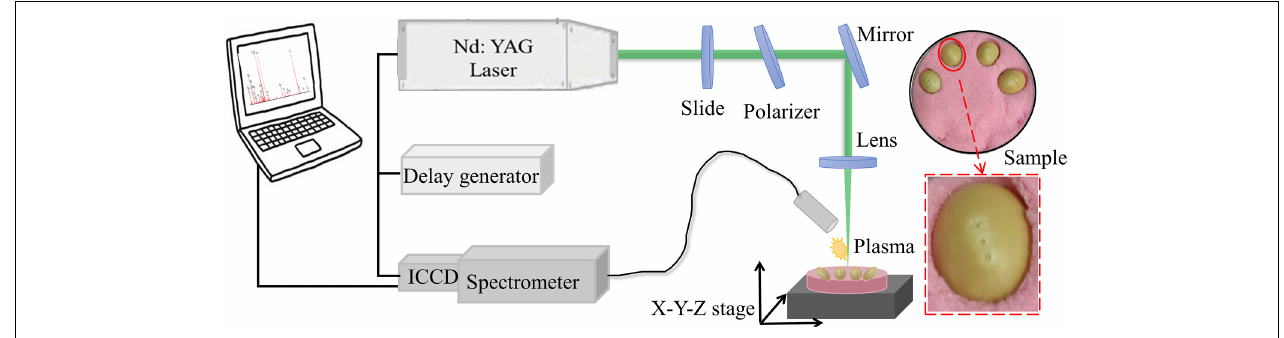
FIGURE 1 | The schematic diagram of the laser-induced breakdown spectroscopy (LIBS) experiment.